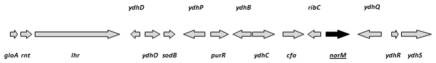
ORFs (arrows) present in the isolated chromosomal fragment.